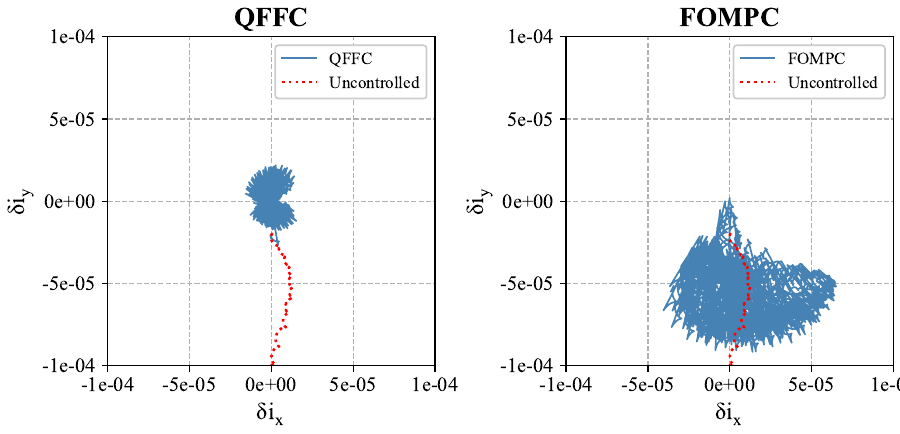
Figure 6. The comparison of the trajectories in the ( δ i x , δ i y ) plane.